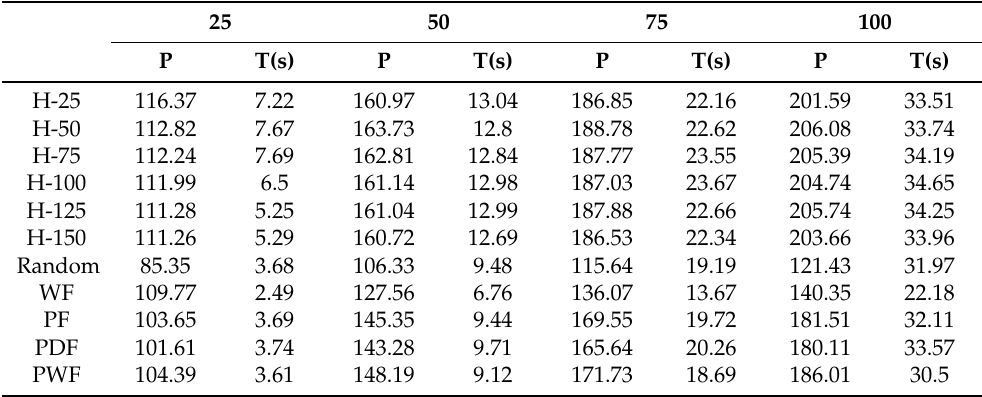
Table 6. Experimental results of scenarios for scale from 25 to 100.